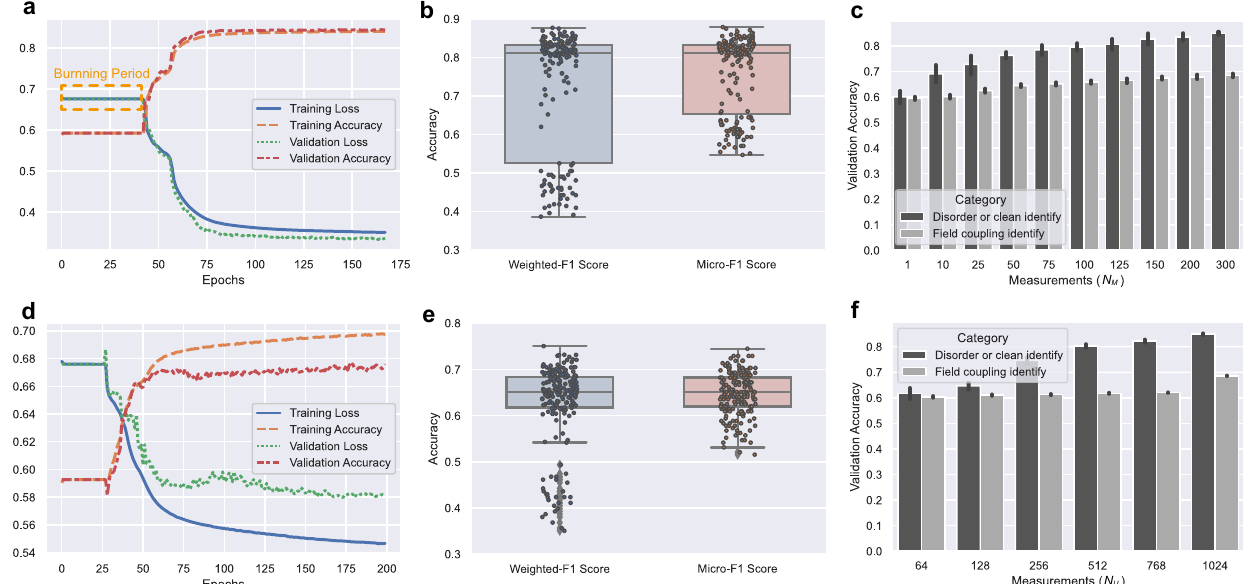
Fig. 2 Machine-learning performance characterized by the loss and accuracy during the training and validation process as well as the Mirco-F1 and weighted-F1 scores for identifying C disorder , C clean and C 420 , C 370 . a The losses continuously decrease as the training epoch increases both in the training and validation dataset. On the contrary, the training and validation accuracy increase correspondingly. The measured bit strings are simulated with N U = 1024, N M = 300. b The Micro-F1 and weighted-F1 scores are demonstrated in a box plot with the maximum accuracy approaching 90%. The box plot is a graphical way to depict data through their quartiles. The small circles in ( b ) and ( e ) denote the actual validation accuracy during training processing. c The performance of two identi fi cation tasks is varied with N M when given N U = 1024. d The losses decrease smoothly after the burning period and the ultimate validation accuracy reaches 68% when given N U = 1024, N M = 300. e The box plot of Micro-F1 and weighted-F1 score of each epoch during 200 epochs. The maximum weighted-F1 and accuracy can reach approximately 75%. f The performance of two identi fi cation tasks varies with different N U when given N M = 300. The error bar in ( e , f ) denotes the standard variance over repeated